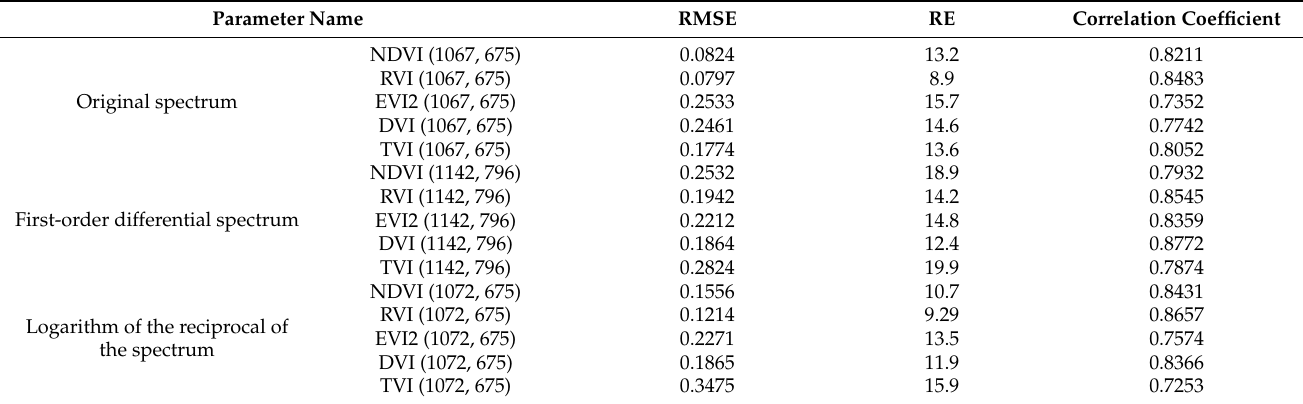
Table 5. The results of the verification of the models to monitor the cotton